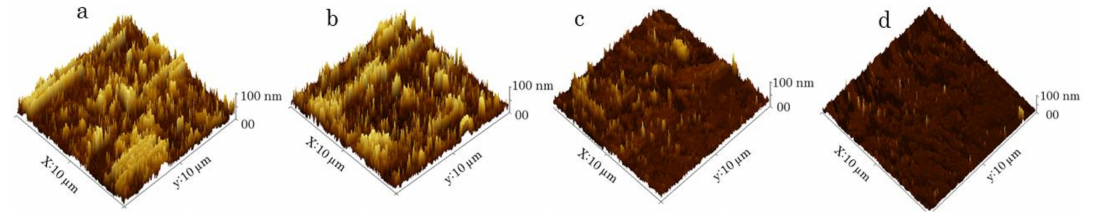
Figure 4. AFM images of CuO nanocoatings ( a ) 700 rpm, ( b ) 800 rpm, ( c ) 900 rpm, and ( d ) 1000 rpm.